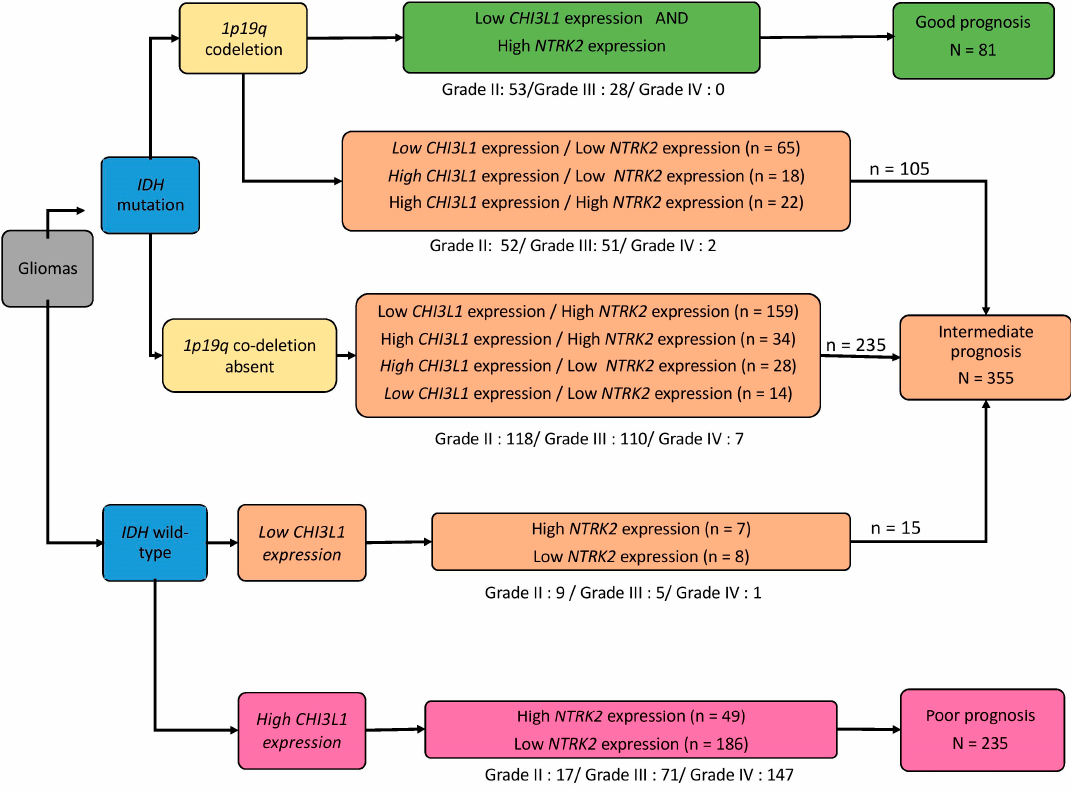
Figure 6. Flowchart summarizing conclusions of the study. Three molecular subgroups based on IDH mutation, 1p/19q co-deletion and CHI3L1 and NTRK2 gene expression status were identified and showed distinct clinical presentations with different prognoses.